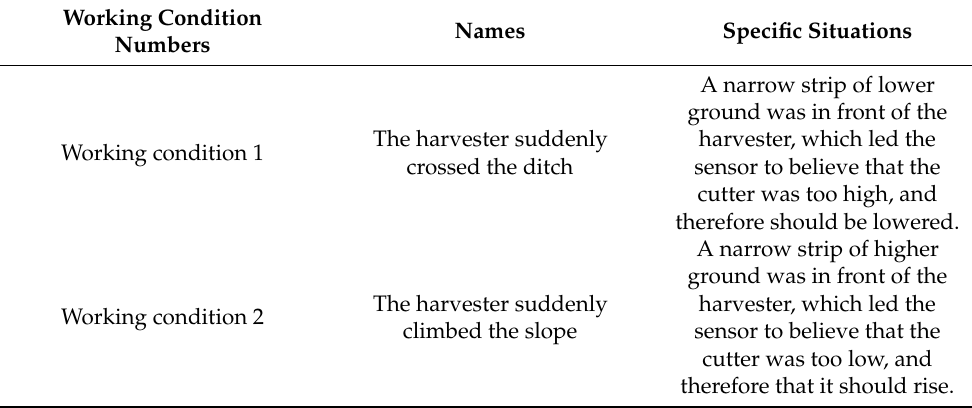
Table 2. Simulation test